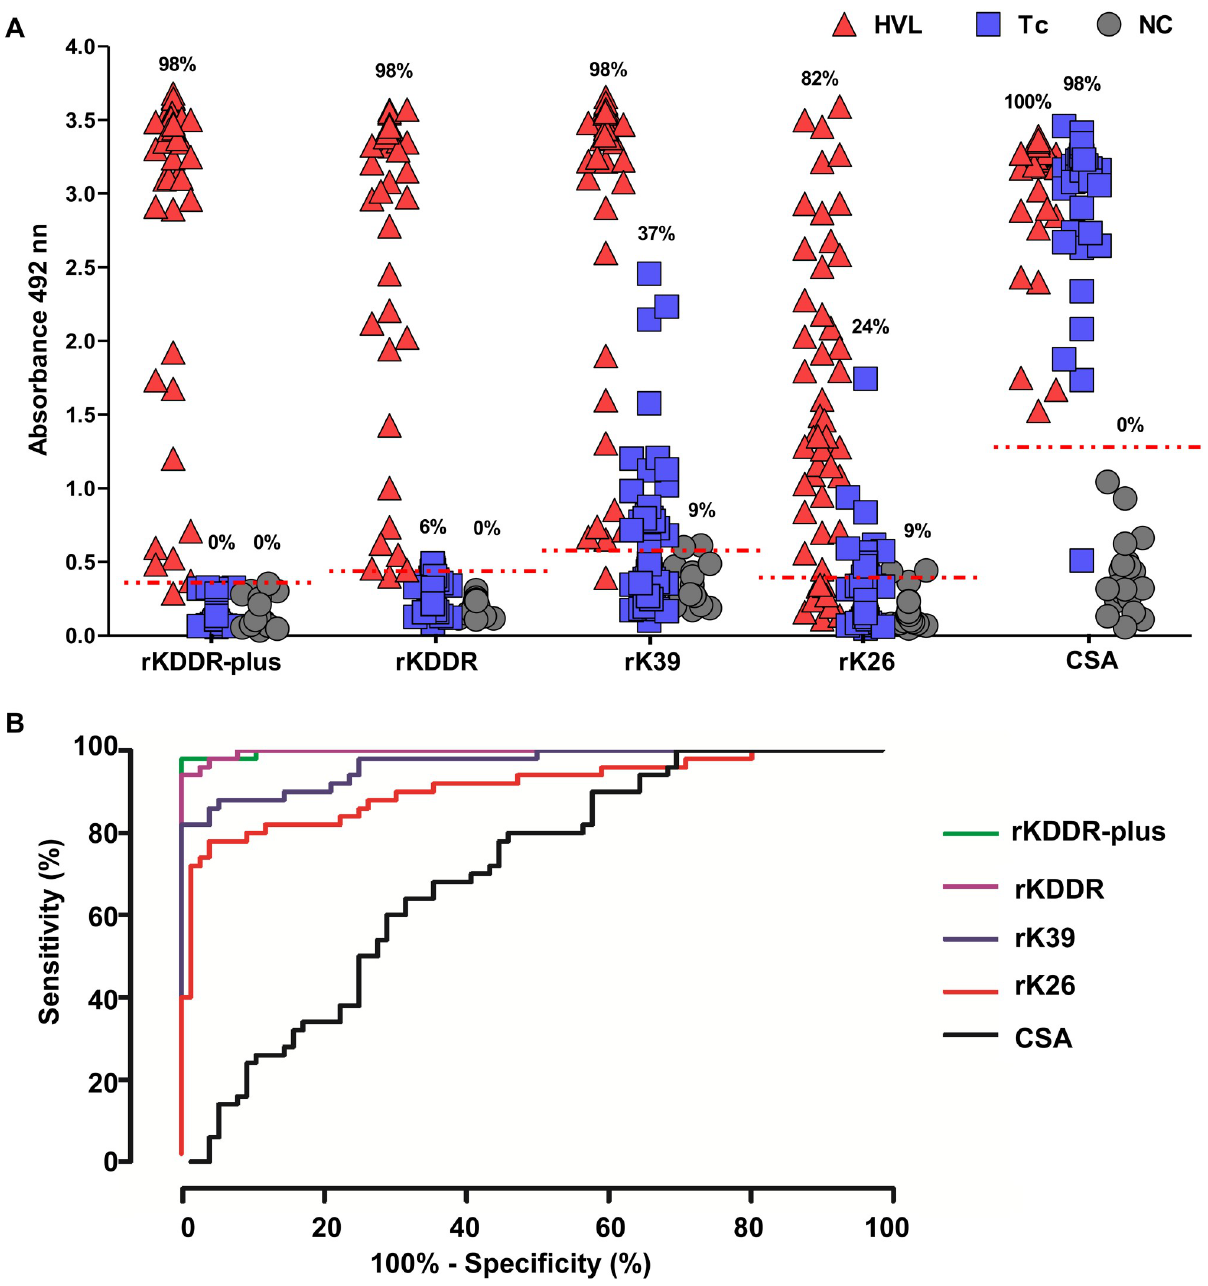
Fig 2. Evaluation of the recombinant antigens and L . infantum crude extract for the serodiagnosis of human visceral leishmaniasis (HVL). (A) Comparison of the performance of ELISA with the rKDDR-plus, rKDDR, rK39 and rK26 antigens and the crude soluble antigen (CSA) of L . infantum was performed using serum samples from the following groups: patients infected with Leishmania (HVL, n = 50); healthy individuals used as negative control (NC, n = 22); and patients chronically infected with T . cruzi (Tc, n = 54), to evaluate cross reactivity. The dashed red line represents the cut-off determined by the ROC curve of each test. The index above each column in the plot indicates the percentage of samples that are above the cut-off. (B) Analysis of ROC curve of each human serological test obtained for ELISA using rKDDR-plus, rKDDR, rK39 and rK26 antigens and the CSA. The sensitivity, specificity and area under the curve (AUC) were determined by ROC